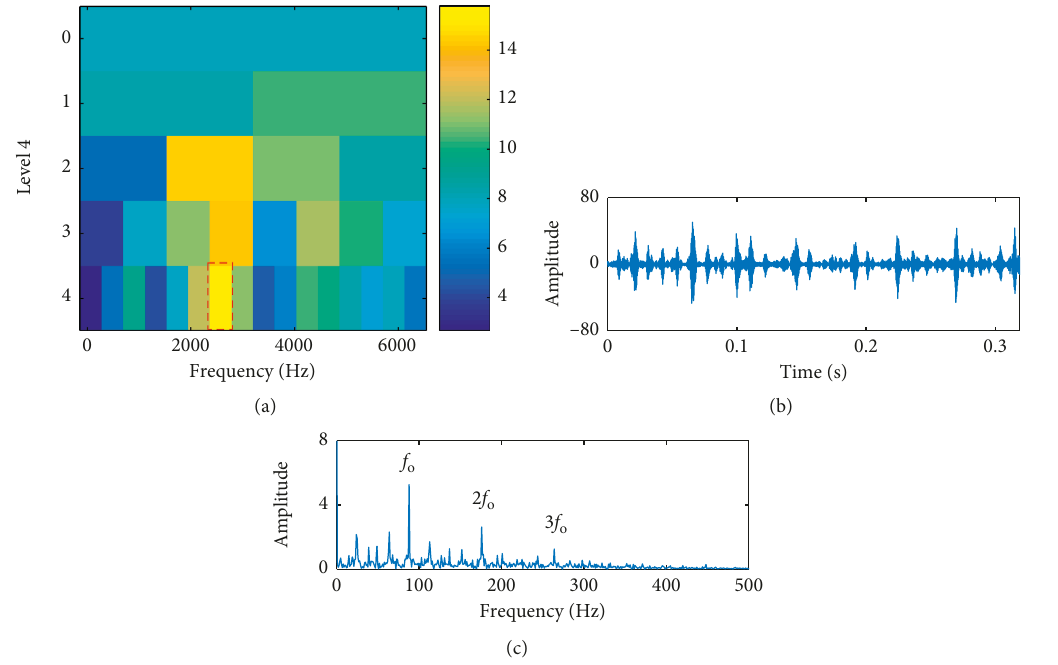
Figure 18: Diagnosis results of the compound fault experimental signal by WPT-FSK: (a) kurtogram; (b) TW of the filtered signal with the maximal kurtosis; (c) ES of (b).